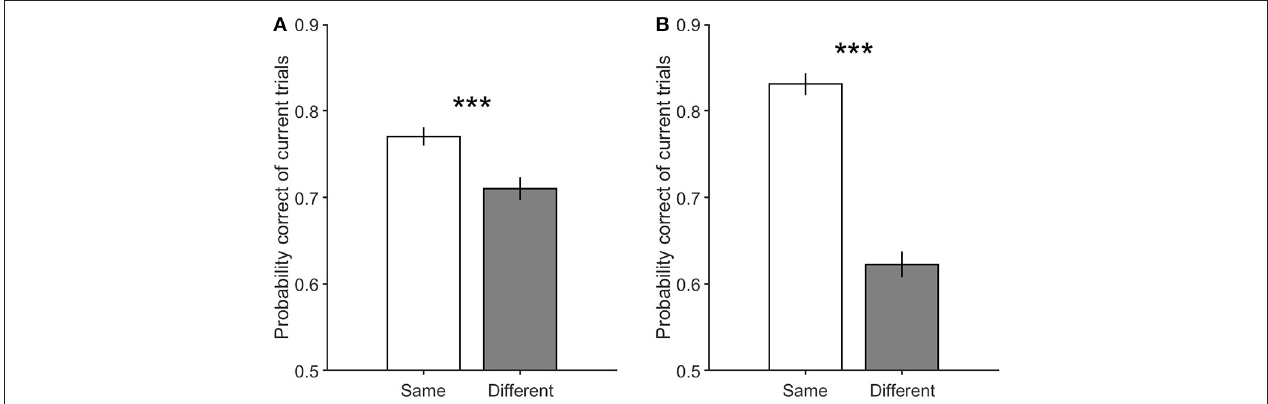
FIGURE 7 | The performance of the current trials which include motion strengths of 3.2, 6.4, and 12.8%. (A) is the performance of the current trials when their previous trials are correct with low motion strengths (0 and 3.2%). (B) is the performance of the current trials when their previous trials are incorrect with low motion strengths (0 and 3.2%). Error bars indicate SE (Standard Error). Wilcoxon rank-sum test is used to test the significance of the differences, *** p < 1E − 3.